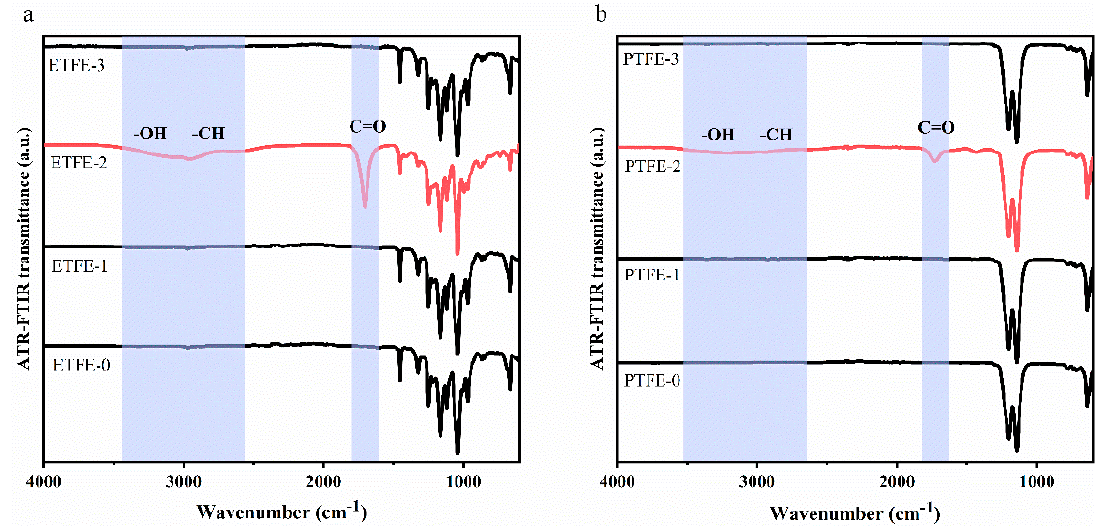
Figure 2. ATR-FTIR analysis of membrane before and after surface treatment: ( a ) ETFE membrane, ( b ) PTFE membrane.